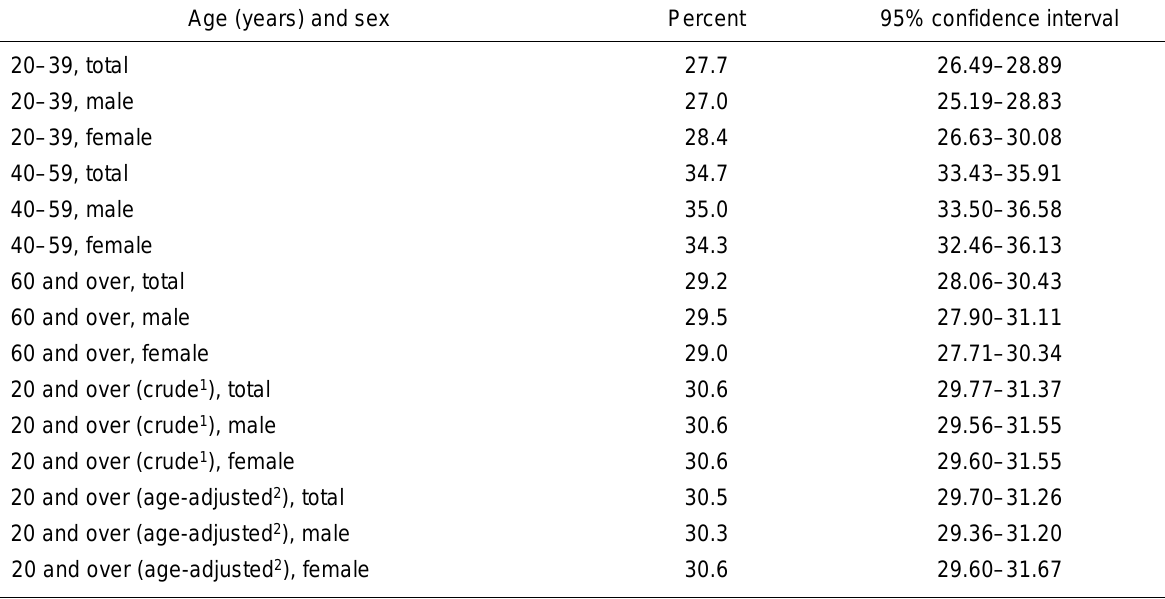
Data table for Figure 6.2. Prevalence of obesity among adults aged 20 and over, by age group and sex: United States, 2016